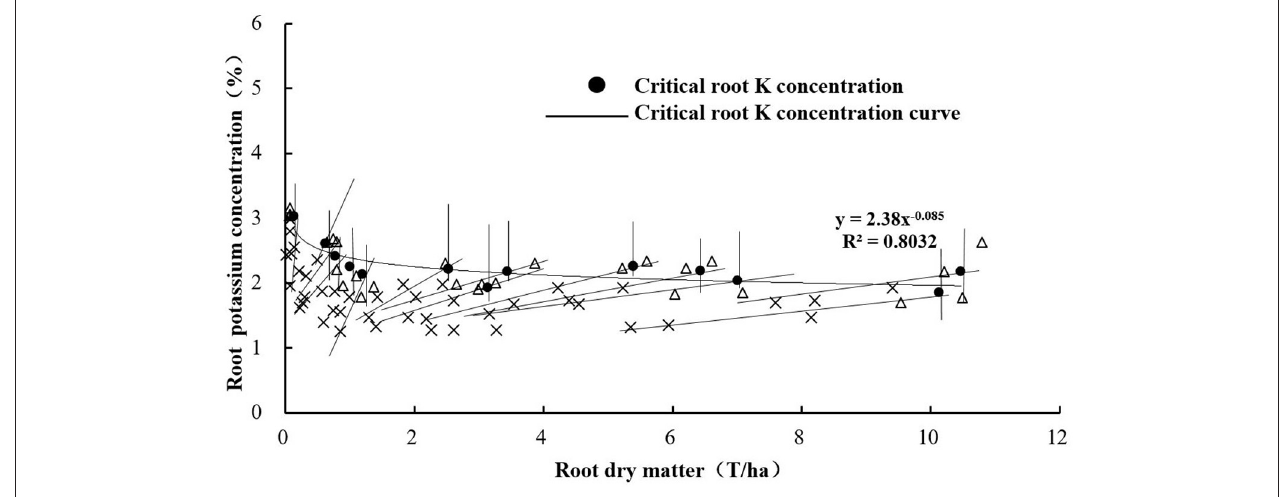
FIGURE 5 | Critical root K concentration curve based on RDM.